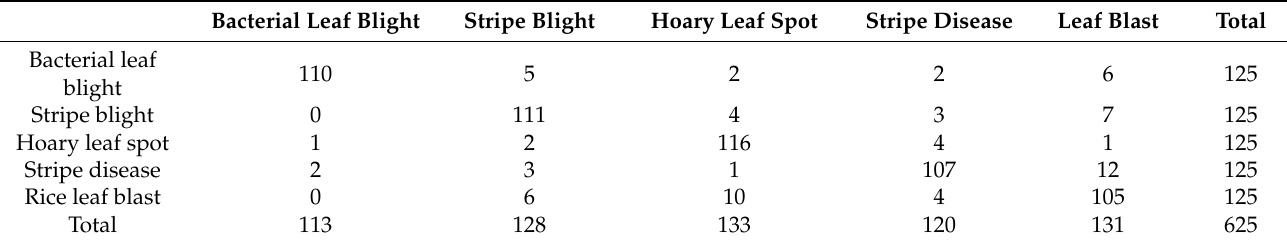
Table 5. Confusion matrix of ResNet-34 network